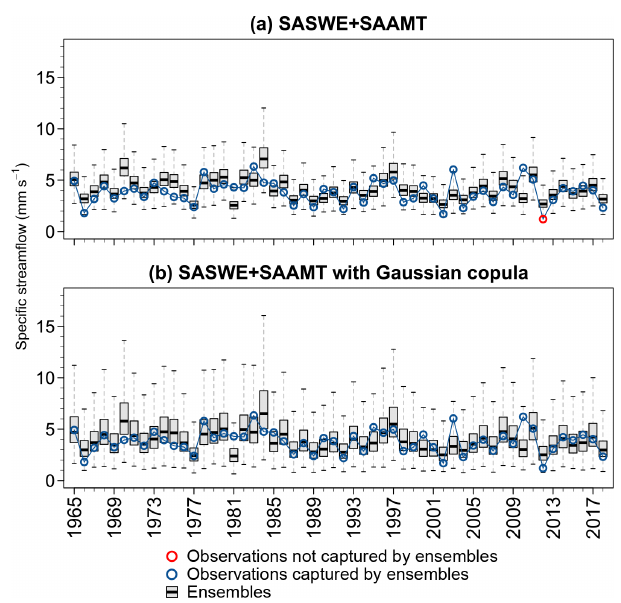
Figure 10. Time series of average projected spring maximum spe- cific streamflow over all seven gauges of the UCRB (mmd − 1 ) from the calibration (1965–2018) for the best model for a 0-month lead time (a) without a Gaussian copula and (b) with a Gaussian cop- ula. Blue and red points indicate observations captured (or not) by the ensemble’s variability, respectively. Whiskers indicate the 95% credible intervals, boxes show the interquartile range, and horizon- tal lines inside the boxes show the median. Outliers are not dis- played. The ensemble refers to the set of projections produced for each year.